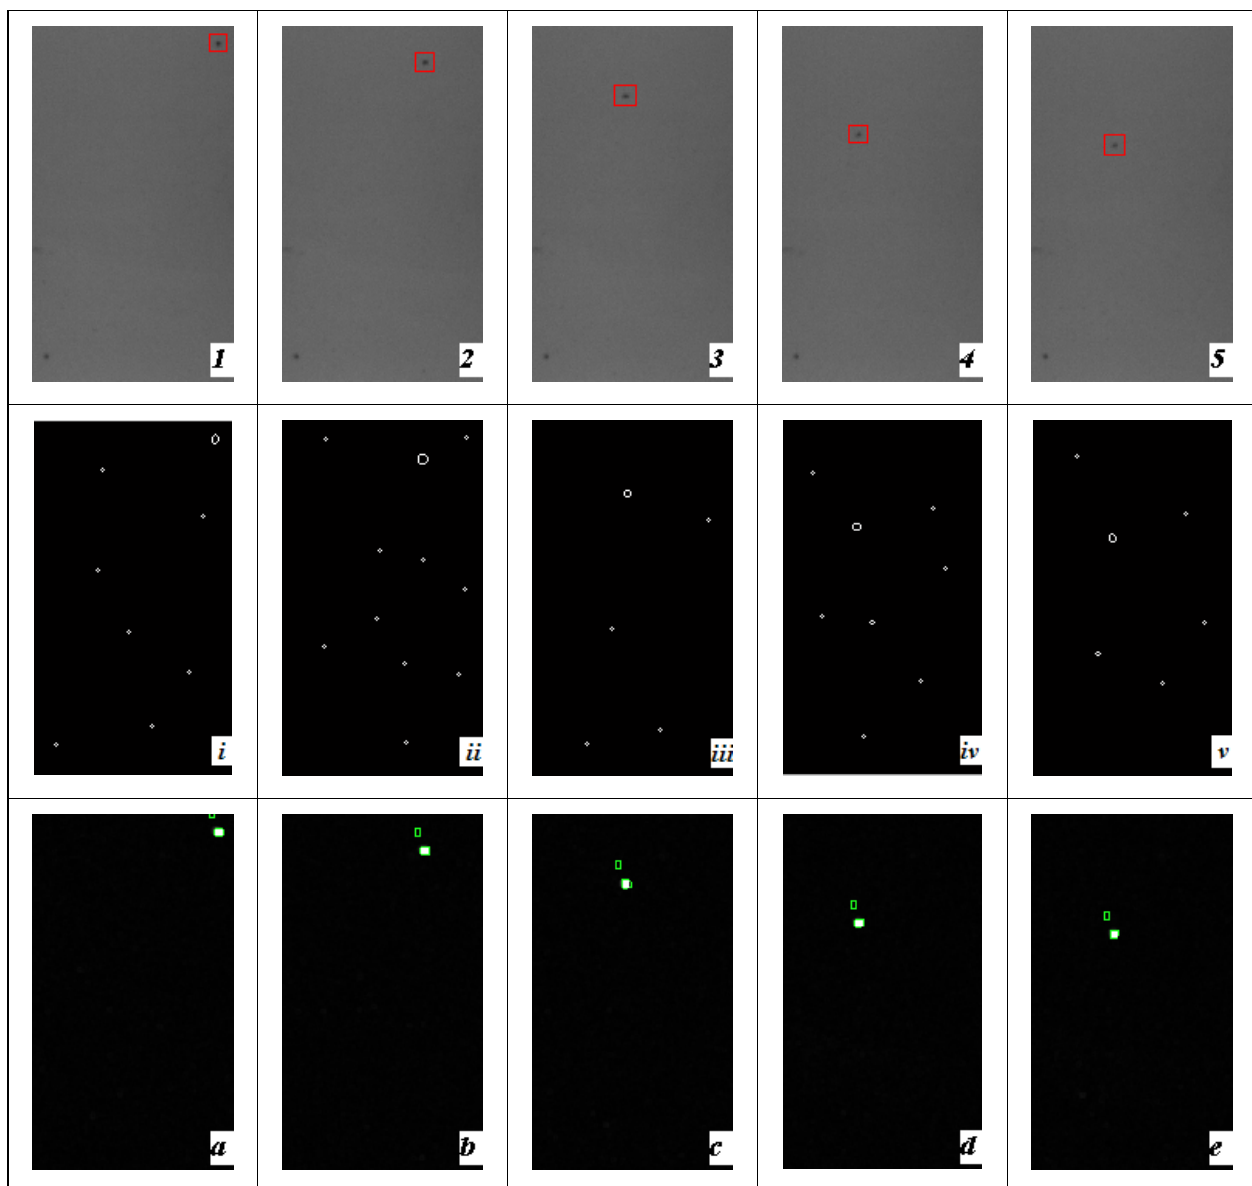
Figure 10. Black foreign particle segmentation with back illumination (1-5) sequential images every 200 ms (the carbide is labeled with red rectangle). (i-v) Segmentation results with Canny operator. (a-e) Segmentation results with modified PCNN (falling black objects are